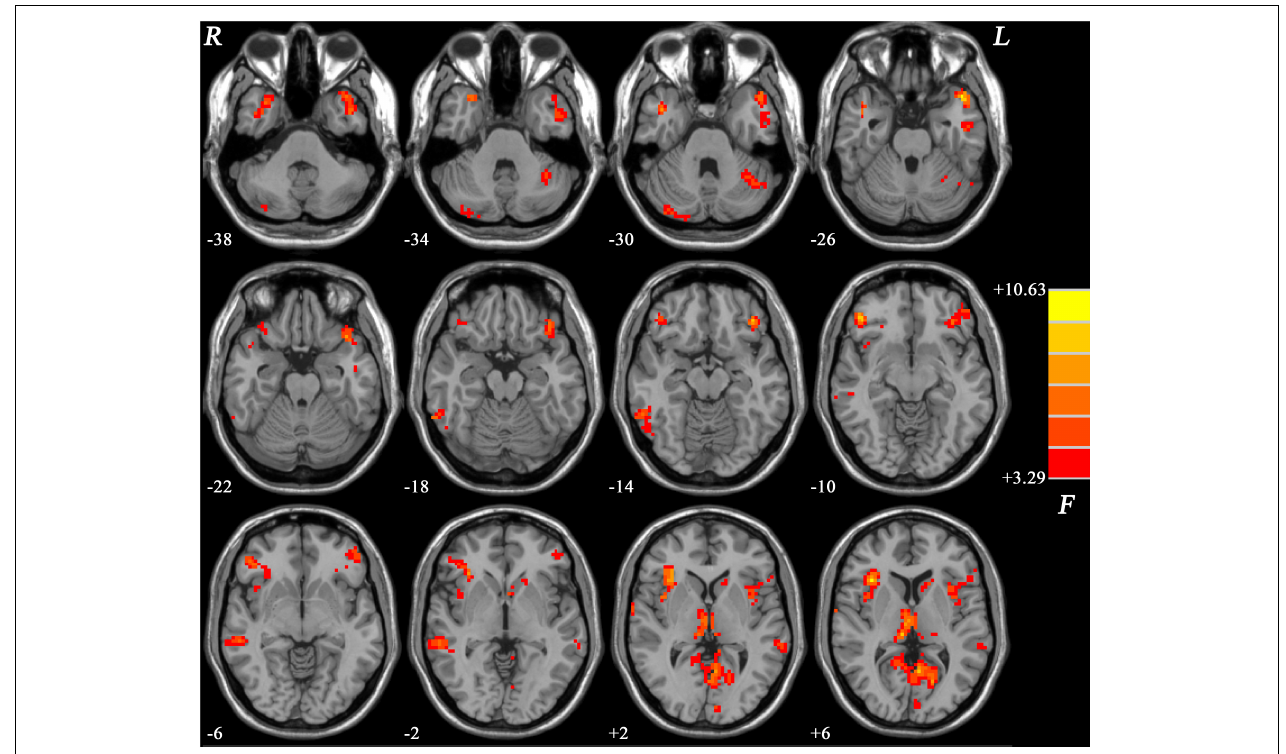
FIGURE 1 | Brain regions showing group differences of GFC values across the three groups. Color bar indicates F values from ANCOVA (age, gender, years of education and framewise displacement as covariates). GFC, global functional connectivity; ANCOVA, analysis of covariance.